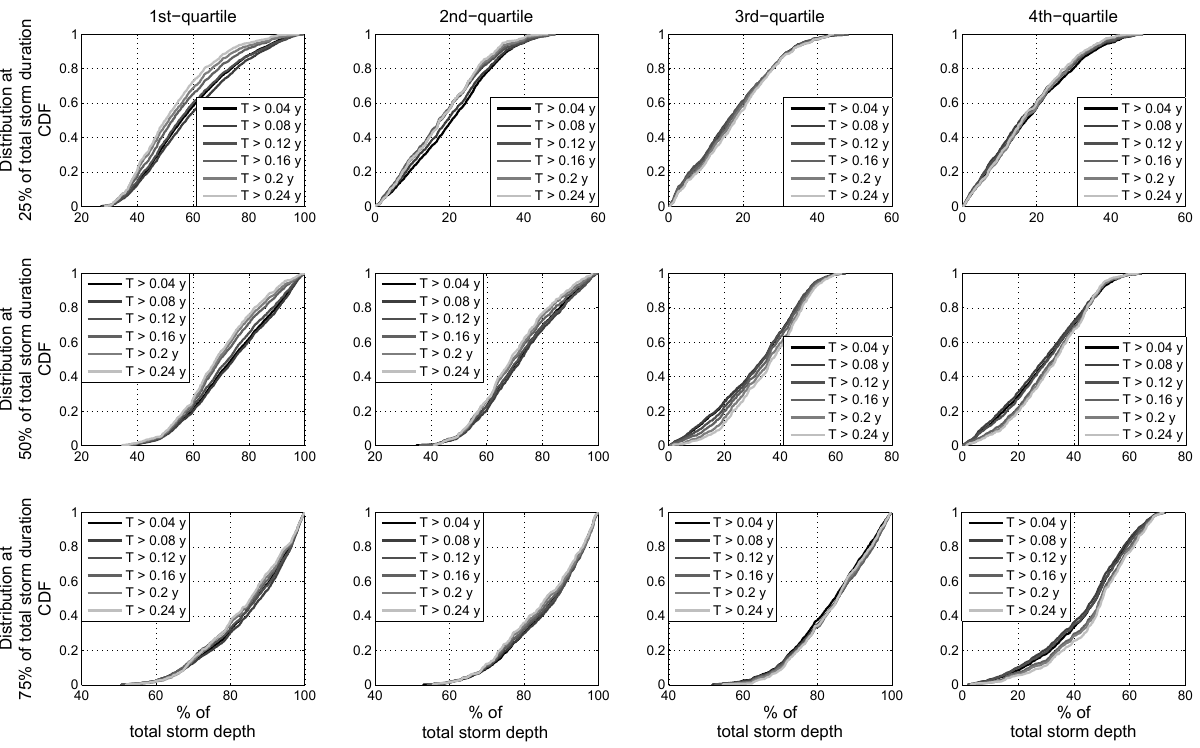
Fig. 6. Comparison of the empirical distribution functions (CDFs) of the percentage of total storm volume (normalized cumulative storm volume) at 25%, 50% and 75% of the total storm duration, considering summer storms for different thresholds on the secondary return period T